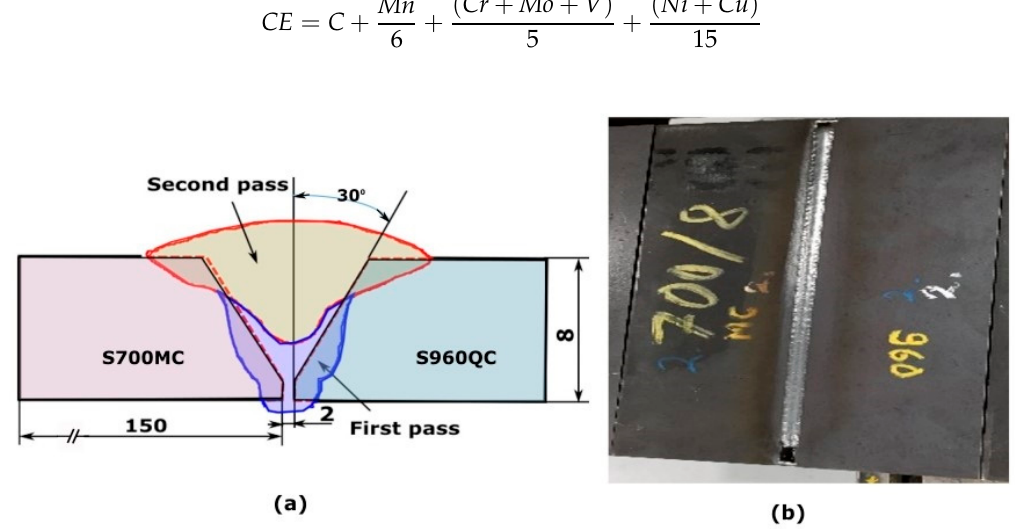
Figure 2. Weld geometry: ( a ) weld joint geometry, ( b ) welded appearance of one specimen. Table 2. Chemical composition and mechanical properties of S700MC and S960QC steels and filler material NiCrMo700. Chemical composition, wt %.